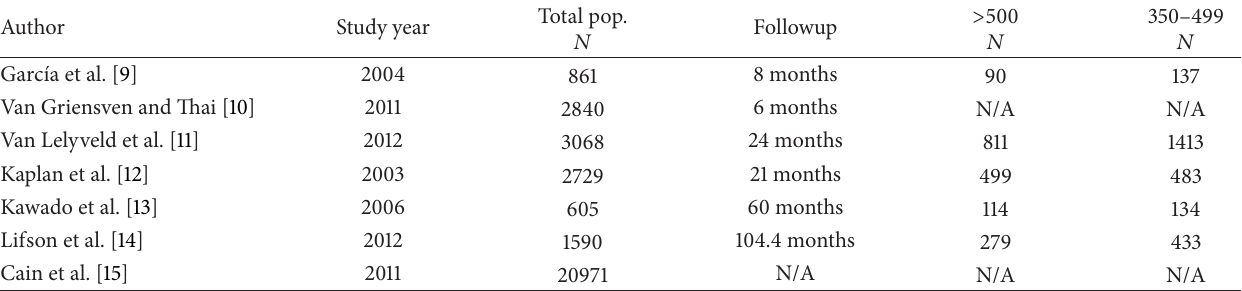
Table 1: Descriptive characteristics of final studies used for systematic review.